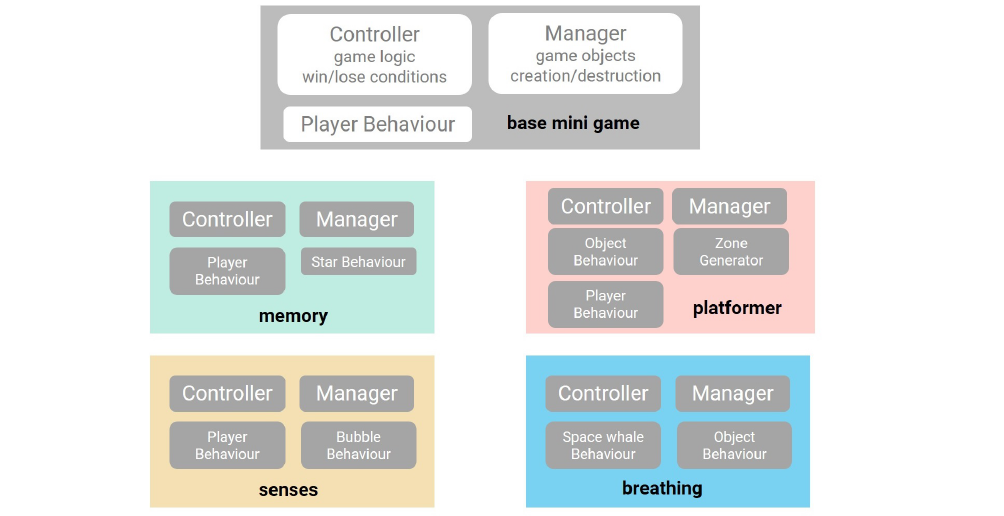
Figure 6. High level overview of the mini-game